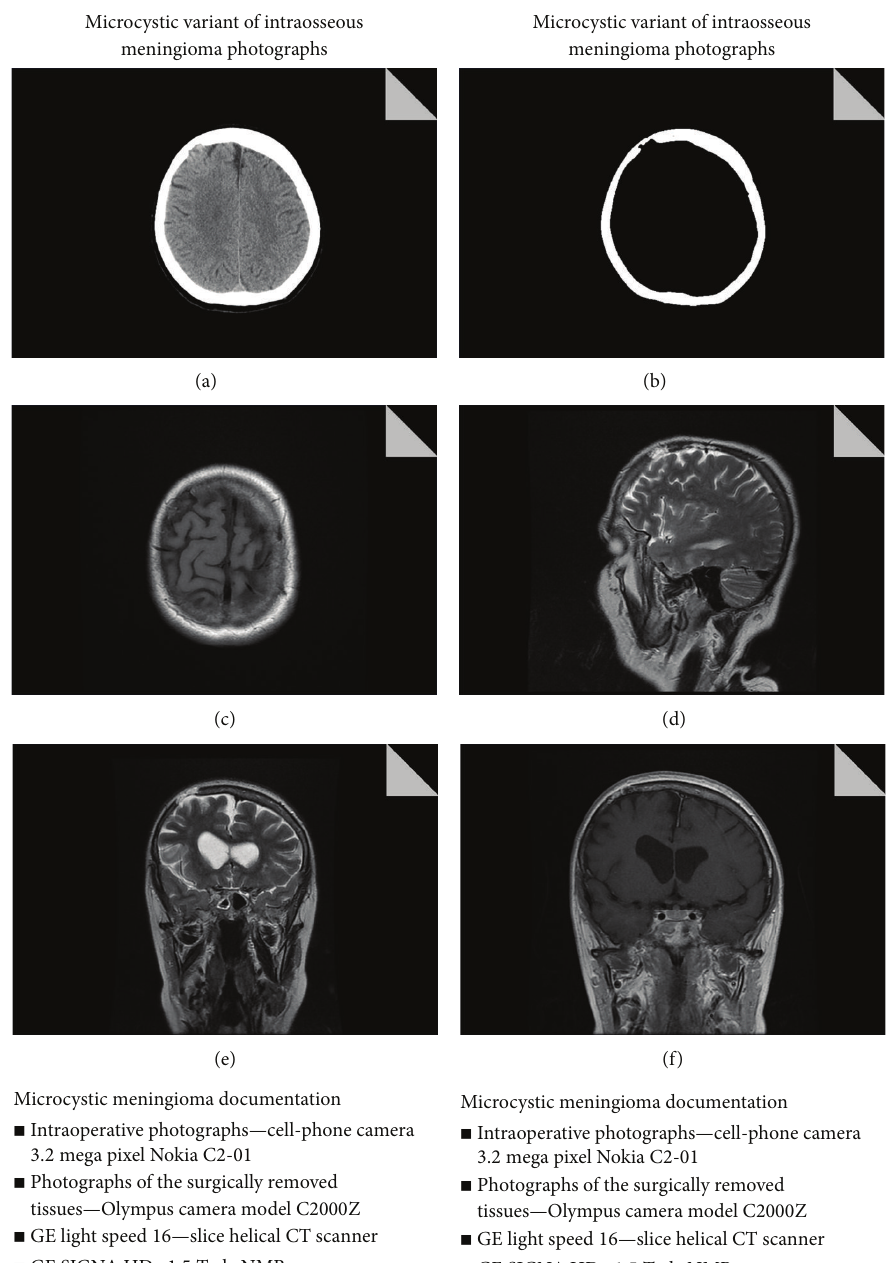
Figure 1: Imaging characteristics: (a) head CT scan, axial projection, and osteolytic defect in the right frontal area in the location of the bone tumour; (b) head CT scan, axial projection, bone window, and osteolytic defect in the right frontal area; (c) MR of the brain, axial projection, T1 SE, and the area of mixed signal intensity inside the bone in the right frontal area; (d) MR of the brain, image in the sagittal plane, and T2 FSE hyperintense area in the right frontal area; (e) MR of the brain, image in the coronal plane, and T2 FSE, hyperintense area in the right frontal area; (f) MR of the brain, image in the coronal projection, T1 following the application of contrast agents, and contrast enhancement features involving only the bone